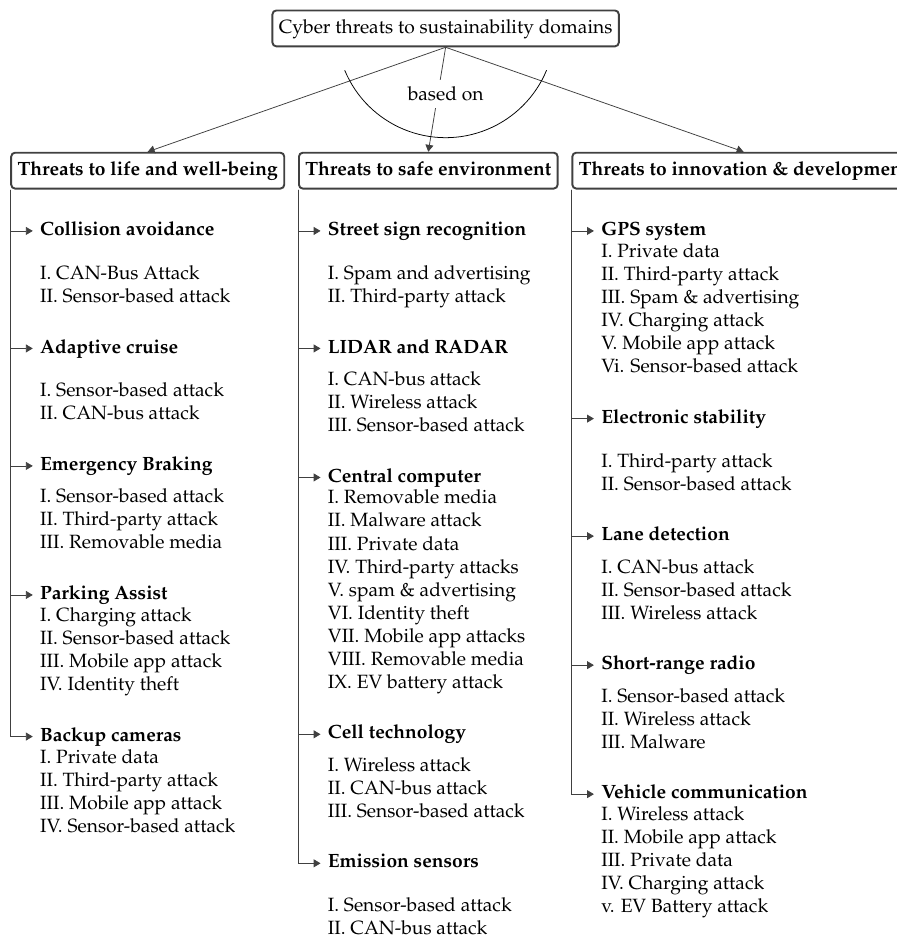
Figure 5. Threats-to-Sensors: second taxonomy that maps security threats to EV